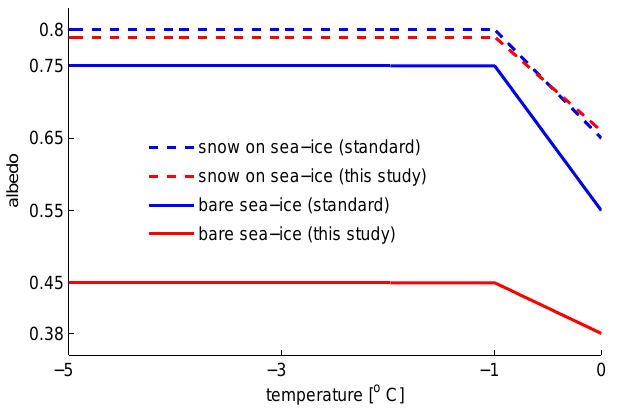
Fig. 3. Simulations with low bare sea-ice albedo. Sea-ice dynamics and ocean heat transport are fully active. Time evolution of annual-mean global sea-ice cover in response to an abrupt change in CO 2 . The simulation with 1112ppm CO 2 was restarted from the 1112ppm CO 2 simulation with high bare sea-ice albedo (Fig.1). Also shown are simulations that start from the state with 70 % sea-ice cover and apply an abrupt increase of CO 2 from 209ppm to various higher levels; these simulations search for the Jormungand bifurcation. All simulations use 94 % solar insolation.